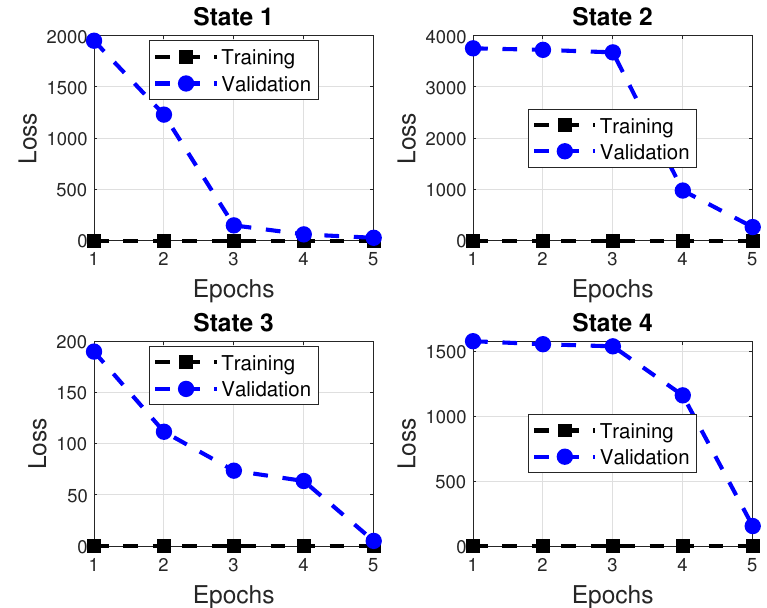
Figure 8. Training and validation MSE losses for XGBoost.